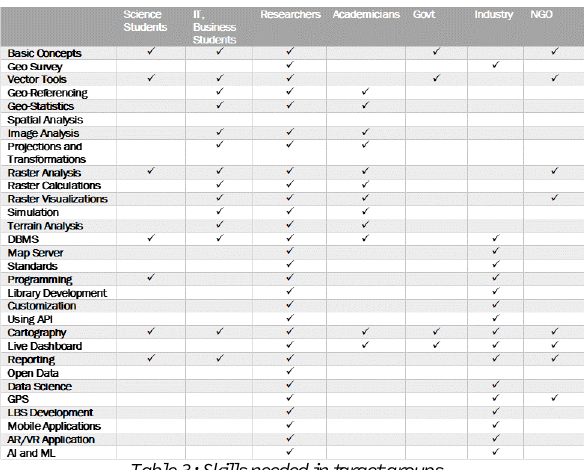
Table 3: Skills needed in target